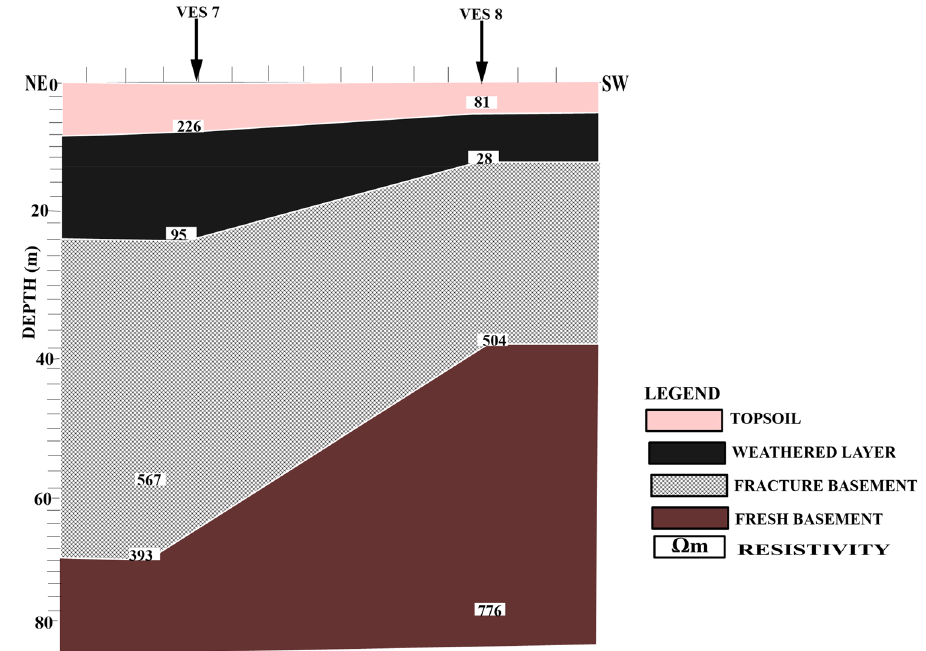
Figure 7. 2D Geoelectric Section along NE–SW Cross Section.